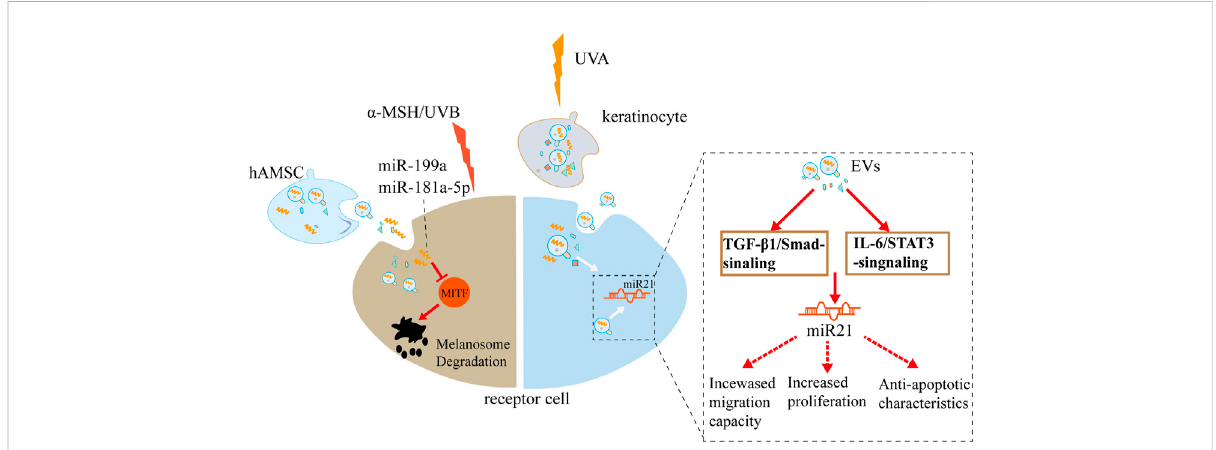
FIGURE 4 Potential effects of EVs on pigmentation: hAMSC-derived exosome and UVA-driven keratinocyte EVs remarkably suppress melanin synthesis, respectively, through multiple signaling pathways. hAMSC, human adipose mesenchymal stem cells; UVA, Ultraviolet Radiation